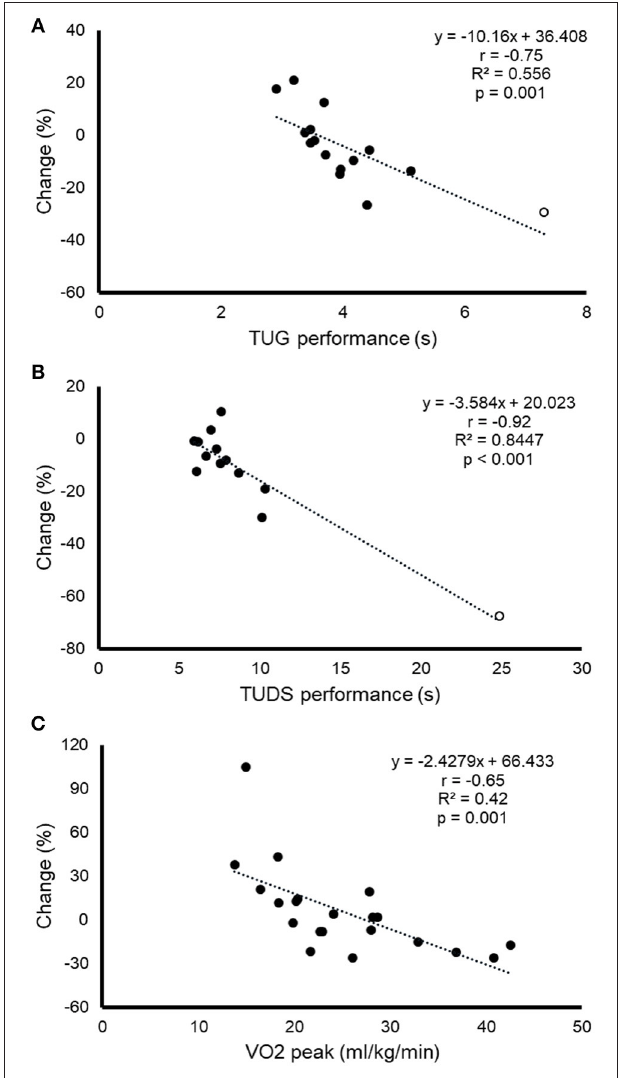
FIGURE 2 | Relationship between baseline performance in bench press (A) , seated row (B) and leg press (C) , on the one hand, and the relative change for performance in each test after the exercise training intervention, on the